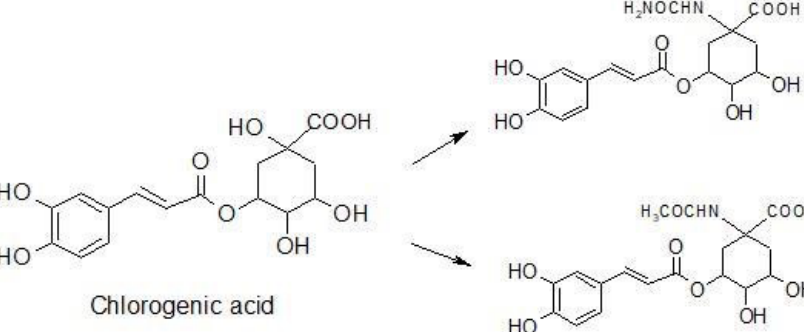
FIGURE 5 - Replacement of the hydroxyl group with urea